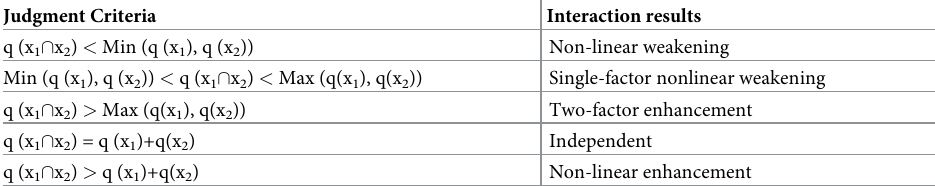
Table 1. Judgment method of two–factor interaction. Judgment